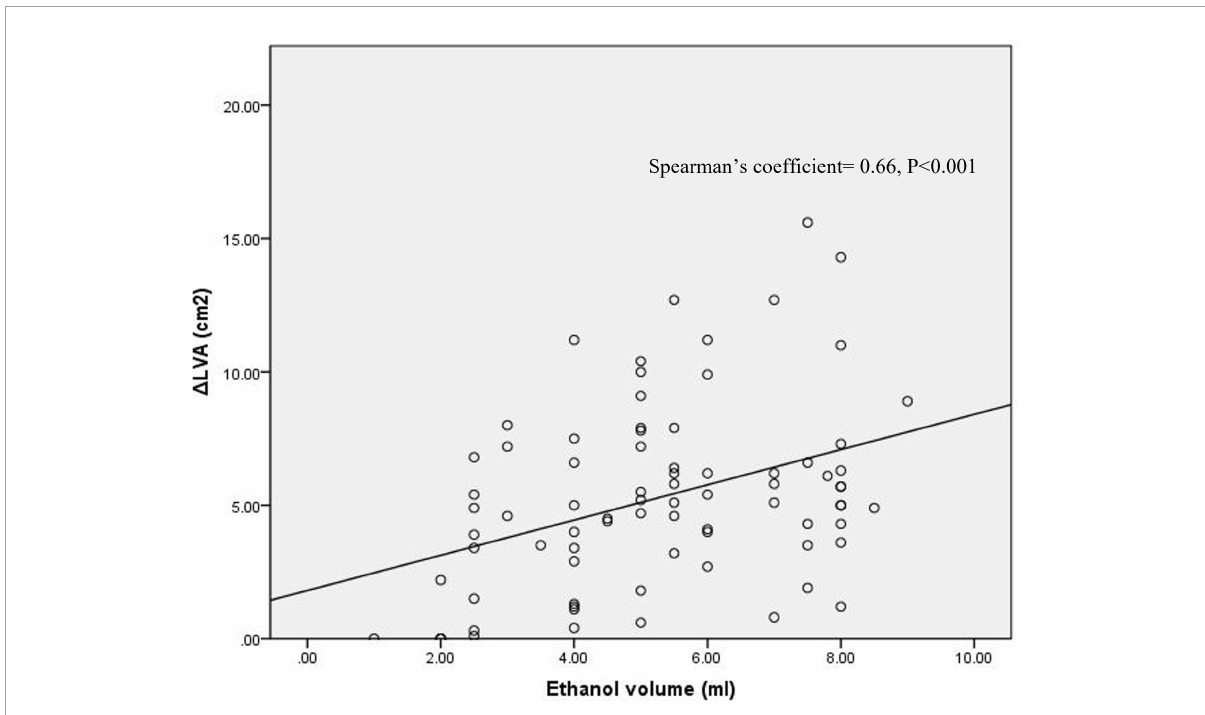
FIGURE4 Correlation of ethanol volume with the size of (cid:49) LVA at the MIth region. Spearman’s coefficient = 0.66, P <